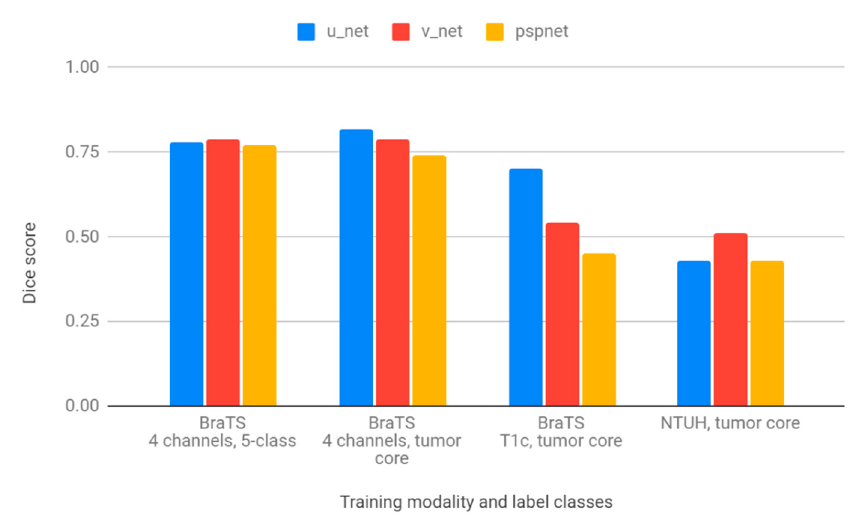
Figure 3. The performance of each model trained with four-channel or one-channel inputs.